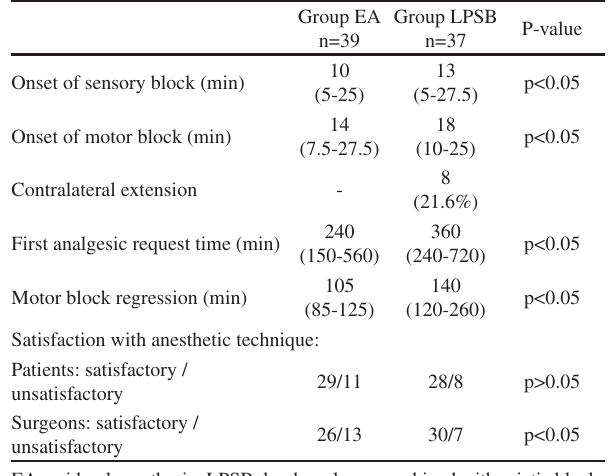
Table 2 - Characteristics of regional anesthetic techniques expressed as median (min-max) or number of patients per category